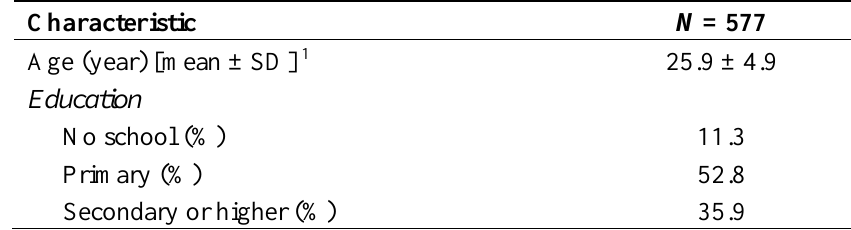
Table 1. Baseline demographics, nutritional status, caloric intake, and clinical characteristics among 577 pregnant women participating in the BAN